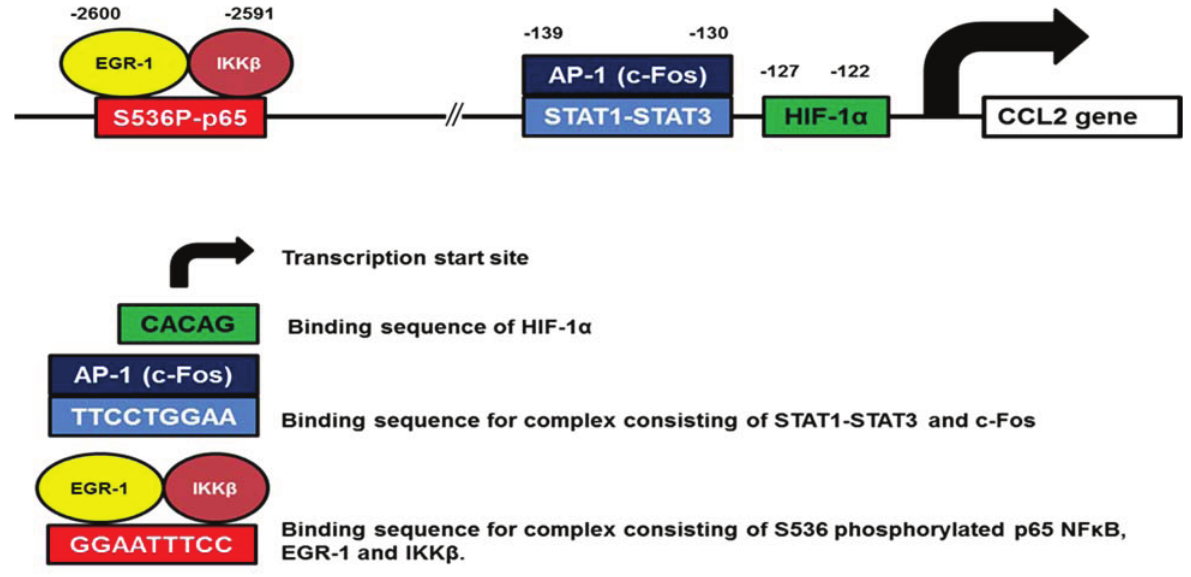
Figure 1. Schematic illustration of human CCL2